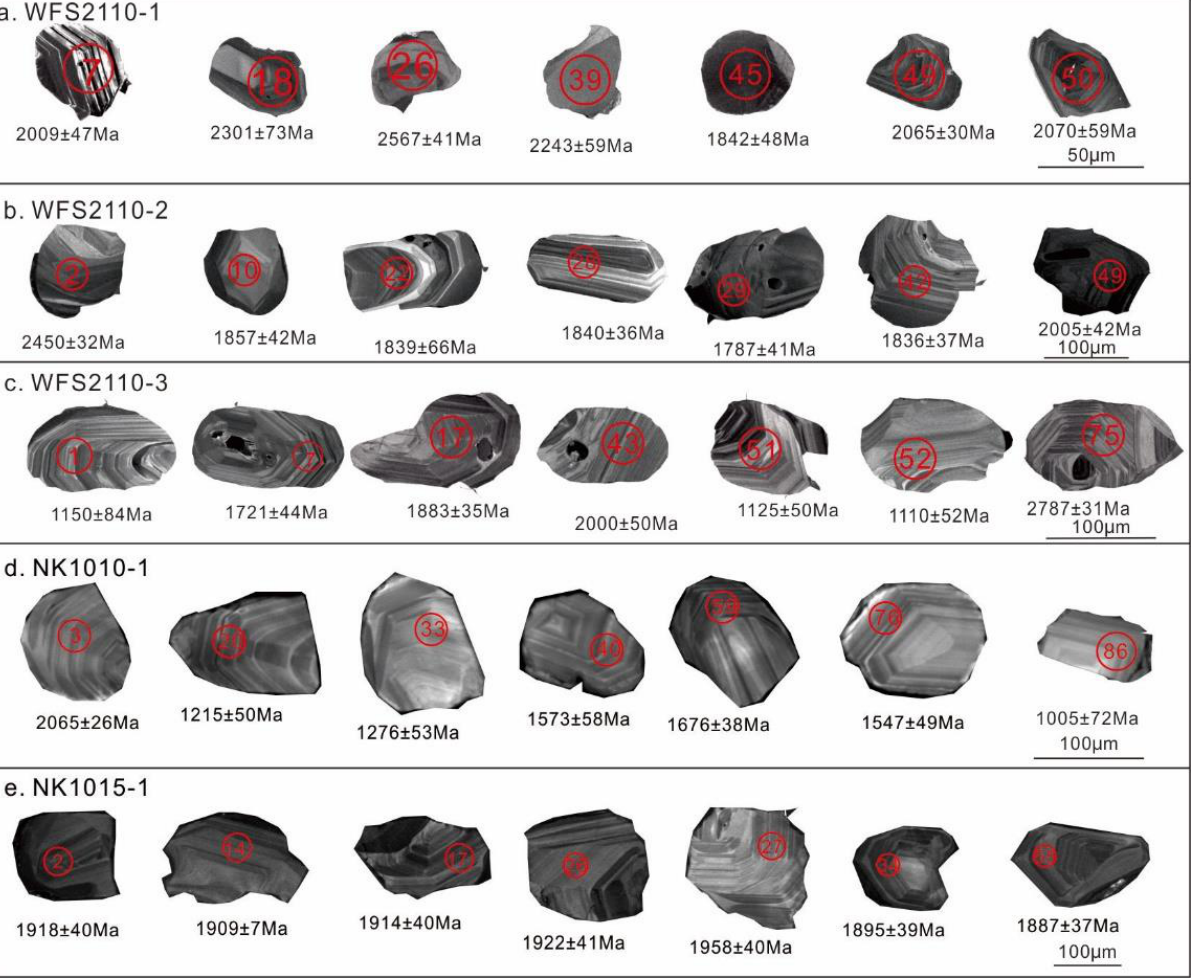
Figure 4. CL images of the representative zircons from the tested samples. Spot diameter for sample WFS2110-1 is ~24 µ m and the others are ~32 µ